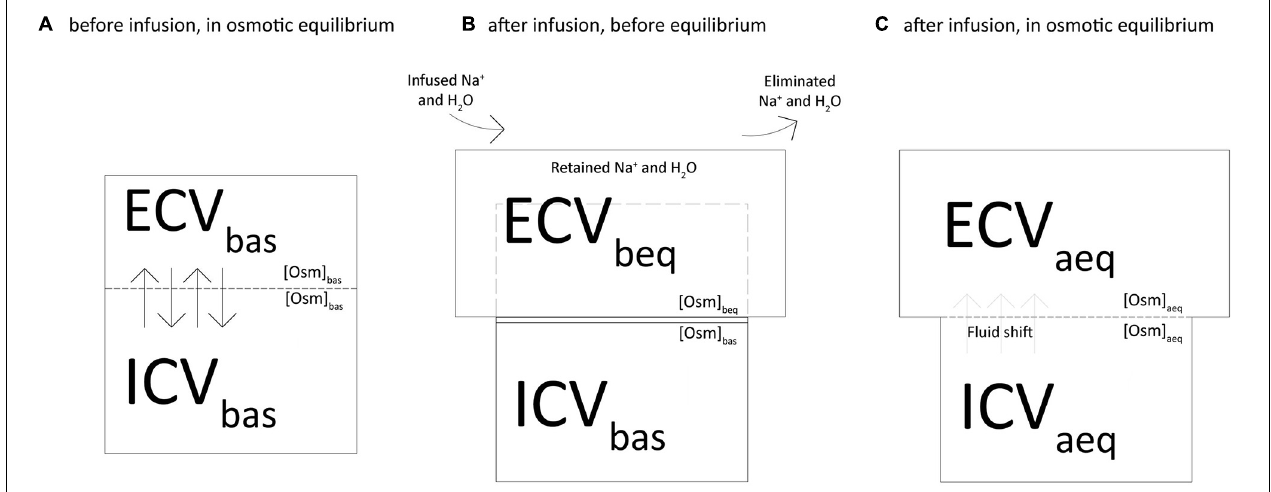
FIGURE 1 | Two-chamber kinetic model to assess the distribution of sodium and fluids across the body